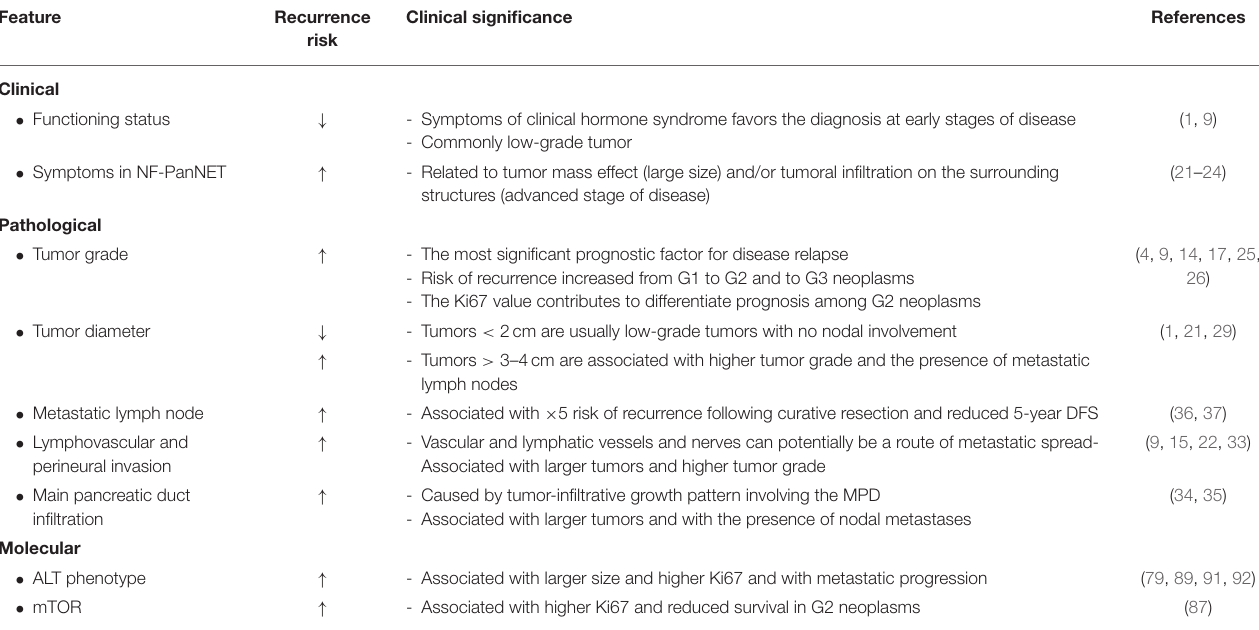
TABLE 3 | Summary of most relevant clinical, pathological, and molecular worrisome features for postsurgical recurrence.